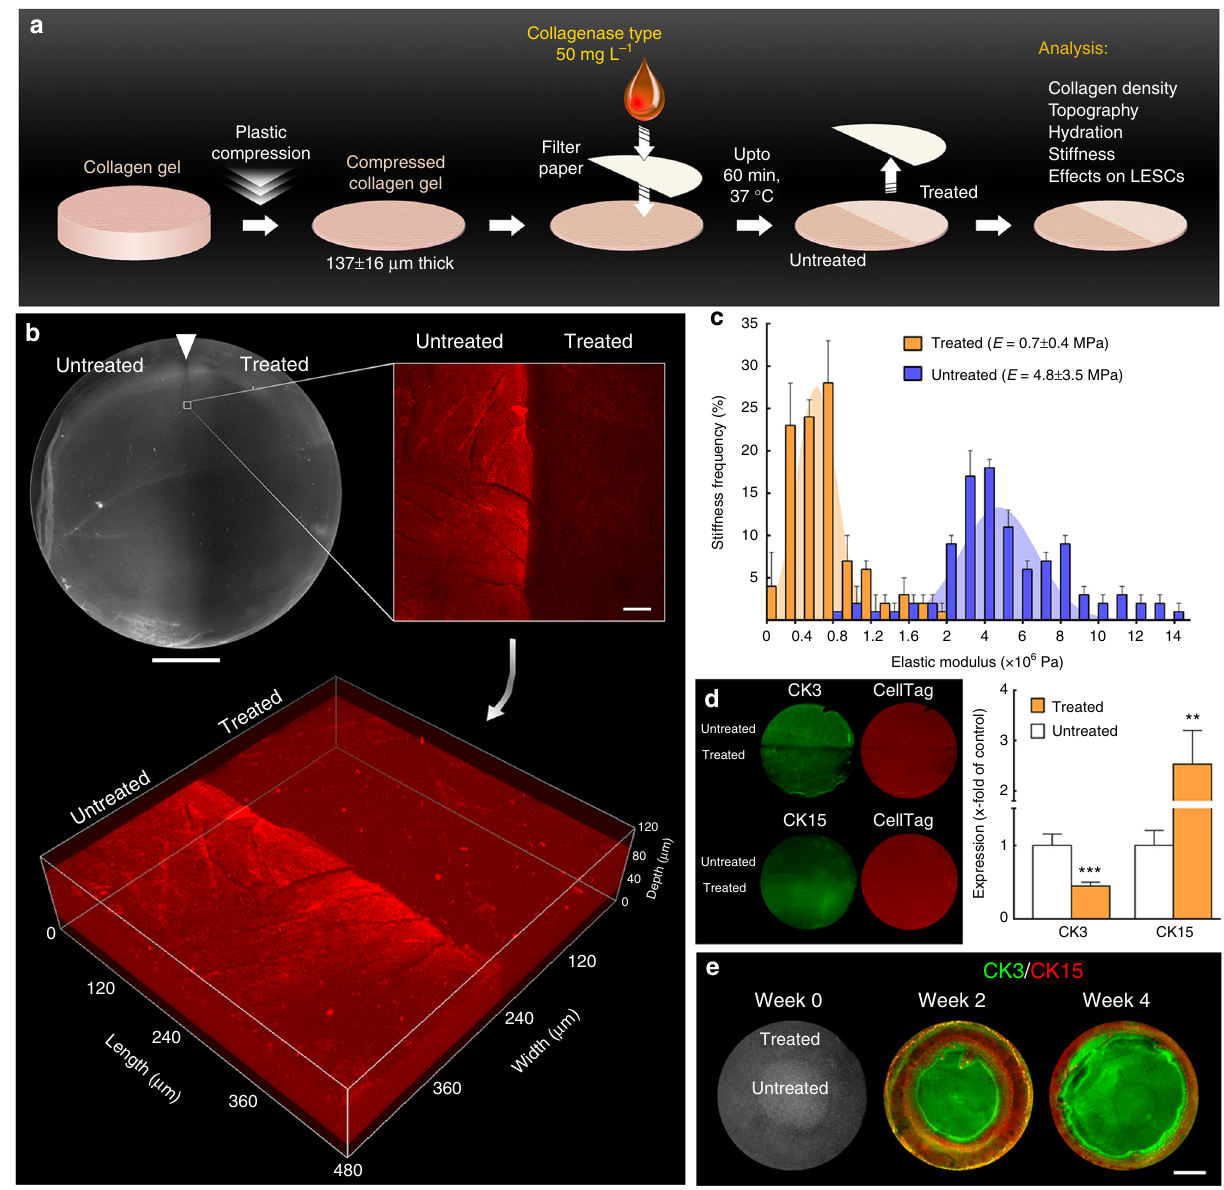
Fig. 3 LESC-like phenotype can be controlled through fi ne modulation of the mechanical properties of collagen substrates. a Schematic representation of the collagenase treatment method used to modulate the stiffness of compressed collagen gels. High-density, plastic-compressed collagen gels were softened with collagenase type-I solution in well-de fi ned areas (ring-shaped, semi-circular, or entire gel surface) for up to 60 min. b Analysis of compressed collagen gel density after collagenase treatment. The regions corresponding to collagenase-treated collagen gels showed increased transparency under bright- fi eld imaging (upper left panel; scale bar, 5 mm) and lower collagen density compared to untreated regions, as indicated by the lower collagen-I detection by immuno fl uorescence confocal microscopy (upper right panel; scale bar, 50 µ m). The confocal Z -scans (lower panel) demonstrated that the difference in signal intensity between treated and untreated areas was not restricted to the surface, indicating that the collagenase in solution acted through the entire depth of the compressed collagen maintaining a de fi ned treatment zone. c Average frequency ± S.D. of the elastic modulus, E (MPa), of treated (orange) and untreated gels (blue bars) calculated from three independent experiments using force – distance spectroscopy ( n = 3). The frequency histograms of treated and untreated gels were used to calculate Gaussian curves by non-linear regression (orange and blue areas, respectively), with corresponding E = 0.7 ± 0.4 and 4.8 ± 3.5 MPa. d Effects of substrate stiffness on the expression of CK3 (differentiation) and CK15 (LESC protein marker) in cells grown for 4 weeks on treated and untreated regions of collagen gels (green staining) after normalisation for total cell number (red staining), and represented as average ± S.D. from three independent experiments ( n = 3; ** and *** corresponds to p < 0.01 and 0.001 after one-way ANOVA, respectively). Source data are provided as a Source Data fi le. e Creation of a pseudo-limbus. Cells growing on ring-shaped softened areas (week 0) expressed higher levels of CK15 compared to the high CK3-positive cells growing on the untreated (stiffer) central region of the collagen gels, up to 4 weeks in culture (scale bar, 5